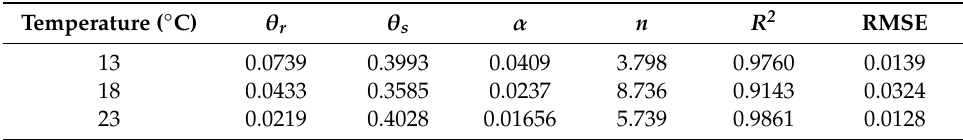
Table 2. Fitting parameters of soil-water characteristic curve (SWCC) at di ff erent temperatures from Ku-pF experiments.